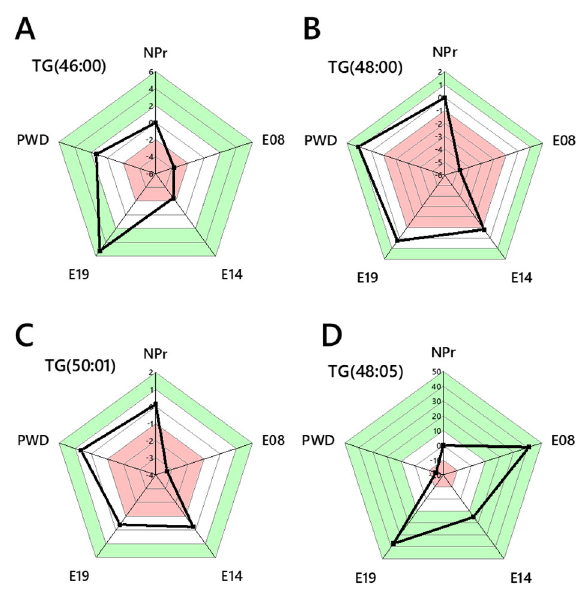
Figure 6. Abundance analysis of TG variables measured at all time points. ( Panel A ) Abundance analysis of TG(46:0); ( B ) TG(48:0); ( C ) TG(50:1); ( D ) TG(48:5). Panels A–C represent TGs associated with de novo lipogenesis, whereas D represents those of mixed and/or dietary origin. NPr, not pregnant; E08, 8th day of pregnancy; E14, 14th day of pregnancy; E19, 19th day of pregnancy; PWD, post-weaning dam.